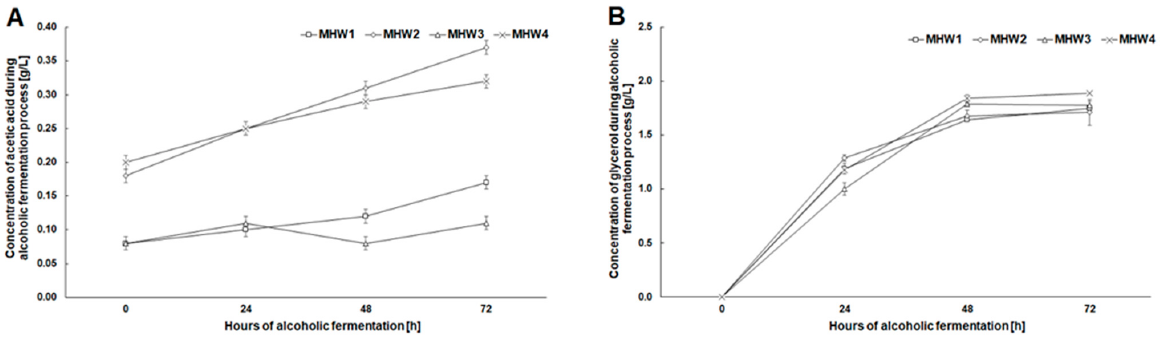
Figure 5. Changes in the concentration of acetic acid ( A ) and glycerol ( B ) during alcoholic fermen- tation for wheat stillage concentrations 143 and 167 g/L after microwave-assisted pretreatment with NaCS.